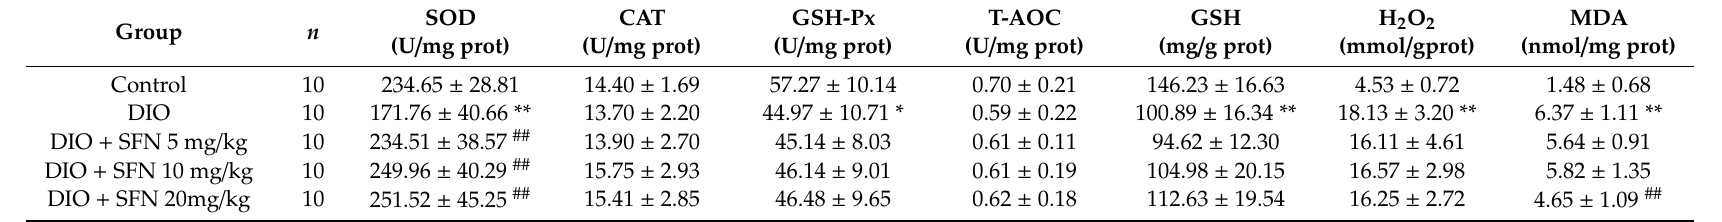
Table 3. E ff ects of SFN on SOD, CAT, GSH-PX, T-AOC, GSH, H 2 O 2 , and MDA levels in obese mice (X ± SD).